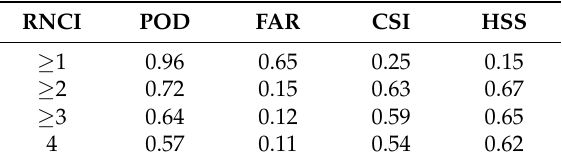
Table 5. Dichotomous statistical indexes corresponding to RNCI